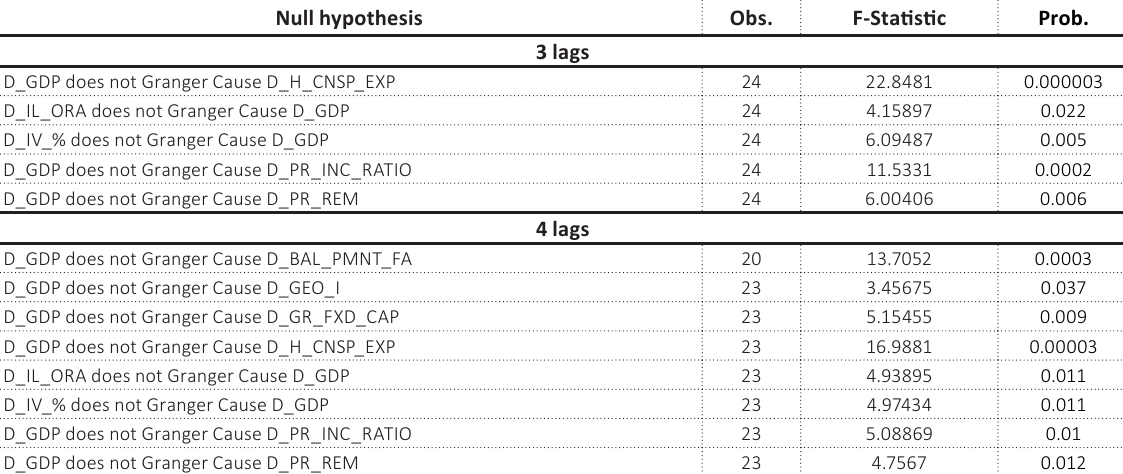
Table 2 (cont.). Statistically significant causal links Null hypothesis Obs.